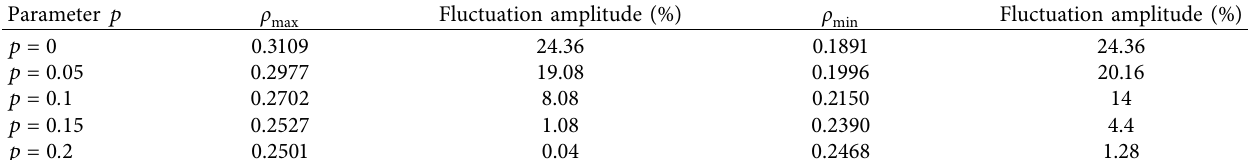
Table 2: Fluctuation amplitude of traffic flow density with different values of parameter p at t � 10 , 300s. Parameter p